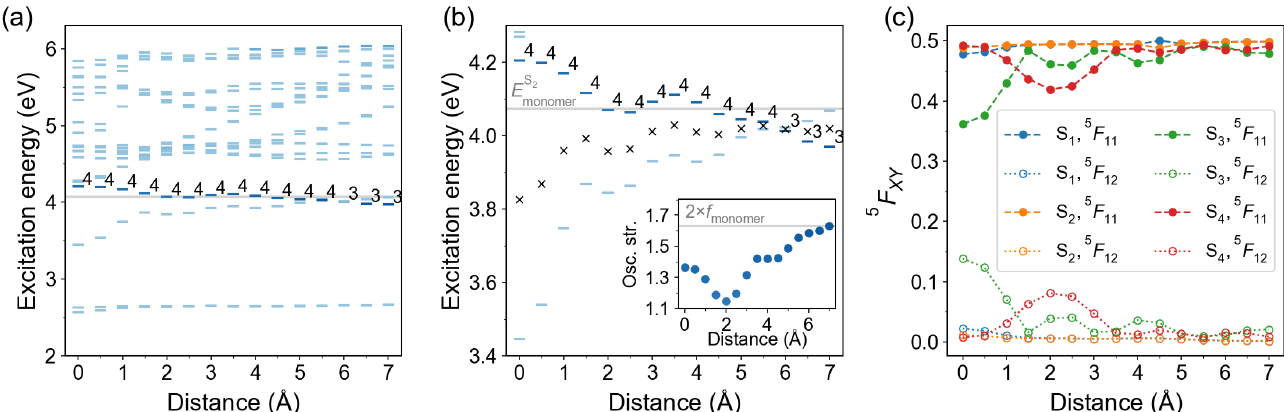
Figure 10. Distance dependence of excitation energies and FTDM matrix elements for slip-stacked azobenzene dimers. ( a ) Excitation energies of twenty lowest transitions. The bars are colored according to the oscillator strength of the transitions, with a darker color corresponding to a larger oscillator strength. The bright state labels are printed. The light grey line marks the excitation energy of the bright monomeric transition S 0 → S 2 . ( b ) Excitation energies of the lowest ππ ∗ states. + E S E S 3 Black crosses show the splitting center . The inset shows distance dependence of the oscillator strength of the bright 4 2 transition. The light grey line in the inset marks twice oscillator strength of the monomeric bright transition. ( c ) FTDM matrix elements 5 F 11 and 5 F 12 quantifying local and CT contributions, respectively, for the lowest four electronic transitions.